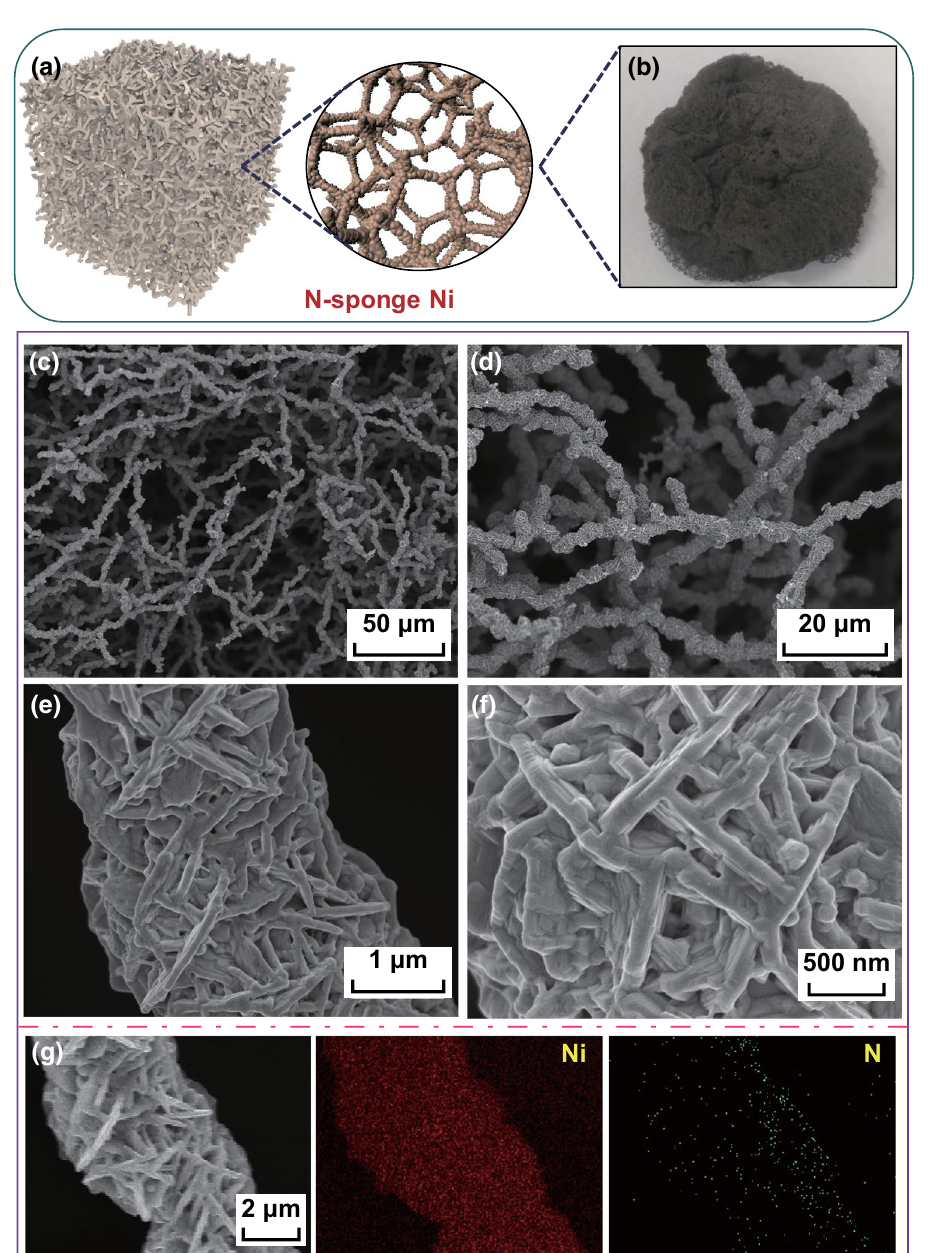
Fig. 1 a Schematic illustration of N-SN. b Optical image of N-SN. c – f SEM images of N-SN. g EDS elemental mapping images of Ni and N in